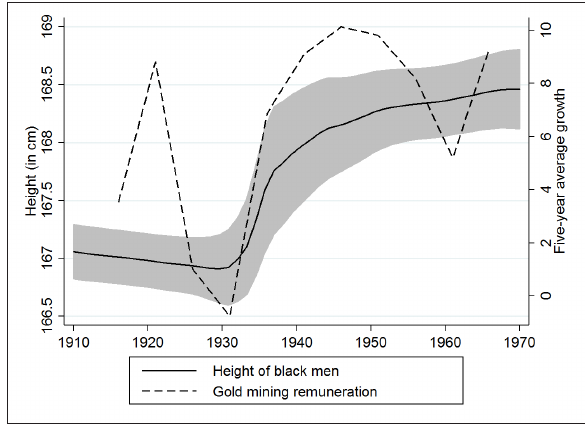
Figure 4: Height of black men and growth in gold mining